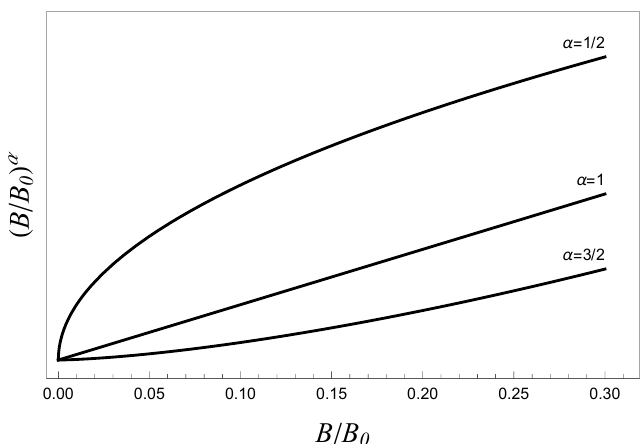
Figure 2: Demonstrating the size of the leading dependencies B α that we find for = ω ∗ / ( 2 ∆ ) . The rigid band case has α = 3 / 2 for various terms, for small B / B 0 0 all harmonics, while the contributions from the mean field to the second harmonic are larger, with α = 1. There are contributions to the third harmonic with α = 1 / 2, which is even larger